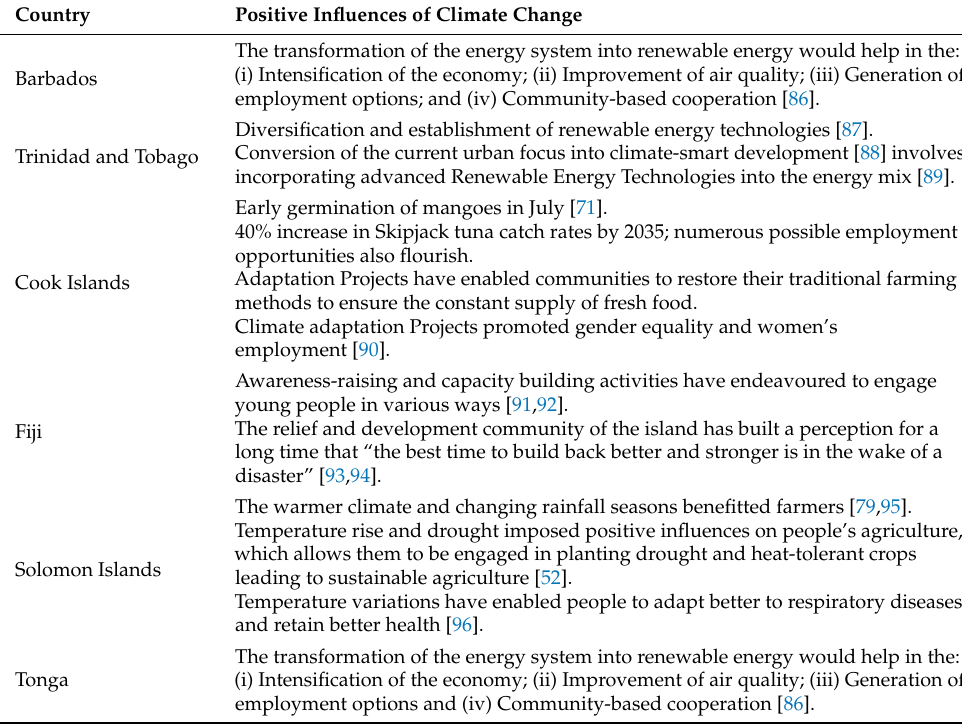
Table 4. Positive influences of climate change.